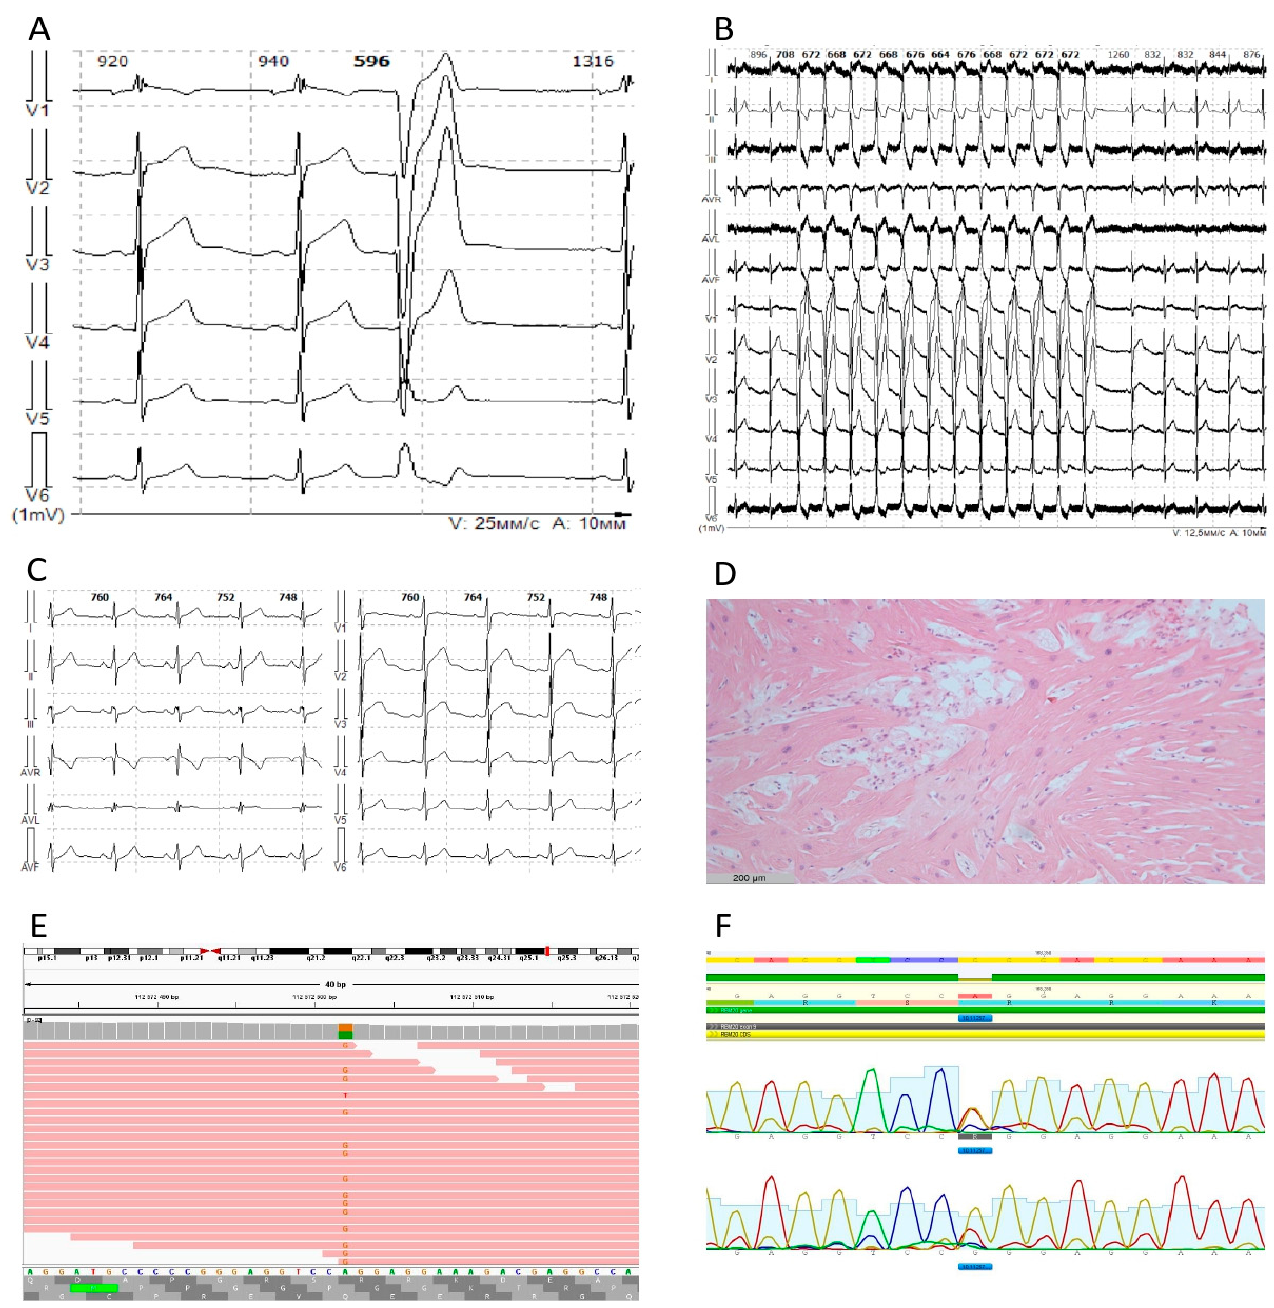
Figure 1. ( A ) Sinus rhythm, single premature ventricular beat. ( B ) Episode of nonsustained ventricular tachycardia. ( C ) ST segment ascending elevation in right precordial leads. ( D ) Myocardial biopsy sample demonstrating cardiomyocyte hypertrophy, disarray, lipomatosis and no gross areas of fibrosis. ( E ) Sequencing reads in IGV (integrative genomics viewer) format, demonstrating c.A2347G:p.R783G substitution in approximately 50% of the reads. ( F ) Sanger sequencing data confirming c.A2347G:p.R783G substitution.